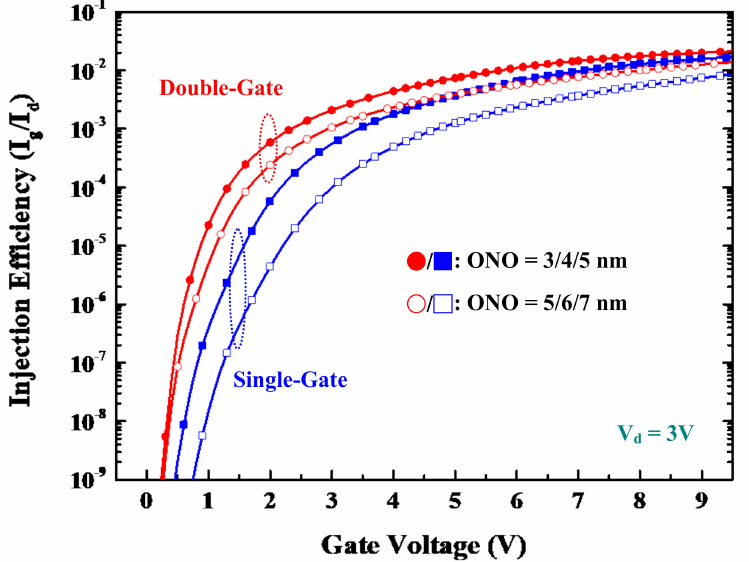
Figure 4. Injection e ffi ciency of single- and double-gate Schottky barrier charge-trapping cells with multi-ONO layers of 5 / 6 / 7 and 3 / 4 / 5 nm at a programming drain voltage of 3